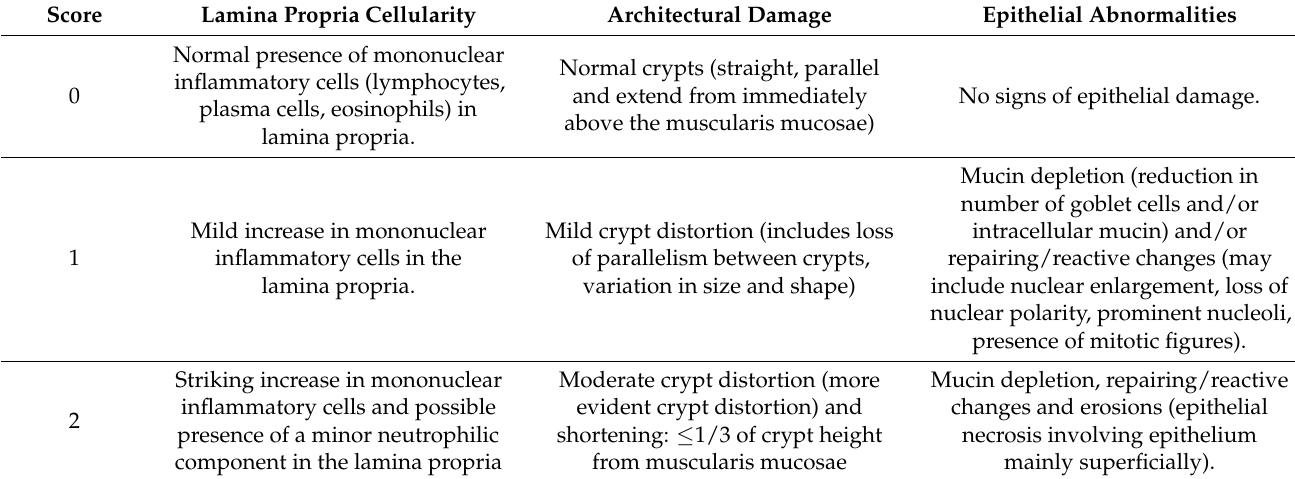
Figure 3. Anatomical distribution of mucosal damage. ( A ) Graph describes the temporal profile of the mucosal damage evaluated at three different time points (5 + 2, 5 + 4,5 + 9) compared to control group (No DSS; n = 10 mice/group) according to three morphological categories (lamina propria cellularity, epithelial abnormalities and architectural damage) scored on the basis of histological scores described in Table 1. ( B – D ) Graph describes the temporal profile (5 + 2, 5 + 4,5 + 9) of the anatomical distribution of the mucosal damage by showing the differences in terms of architectural damage ( B ), epithelial abnormalities ( C ) and lamina propria cellularity ( D ) between the proximal and the distal part of the colonic mucosa.